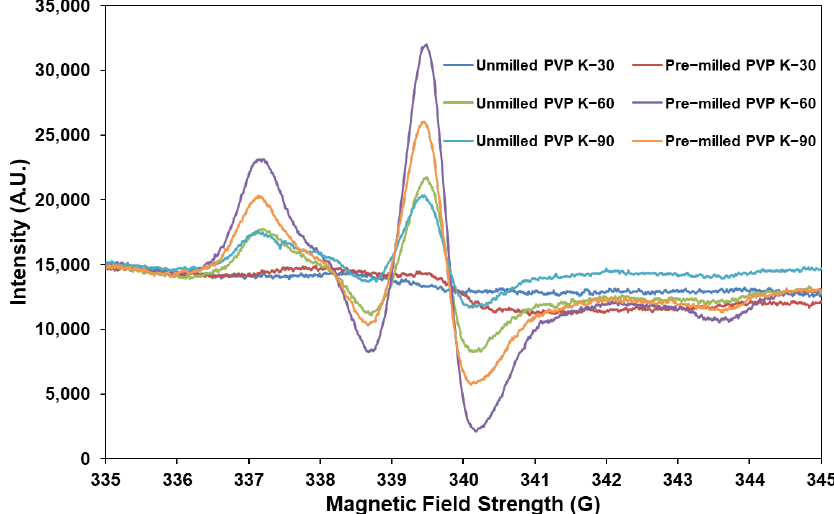
Figure 5. Enhancement of hyperfine signals in pre−milled povidones.